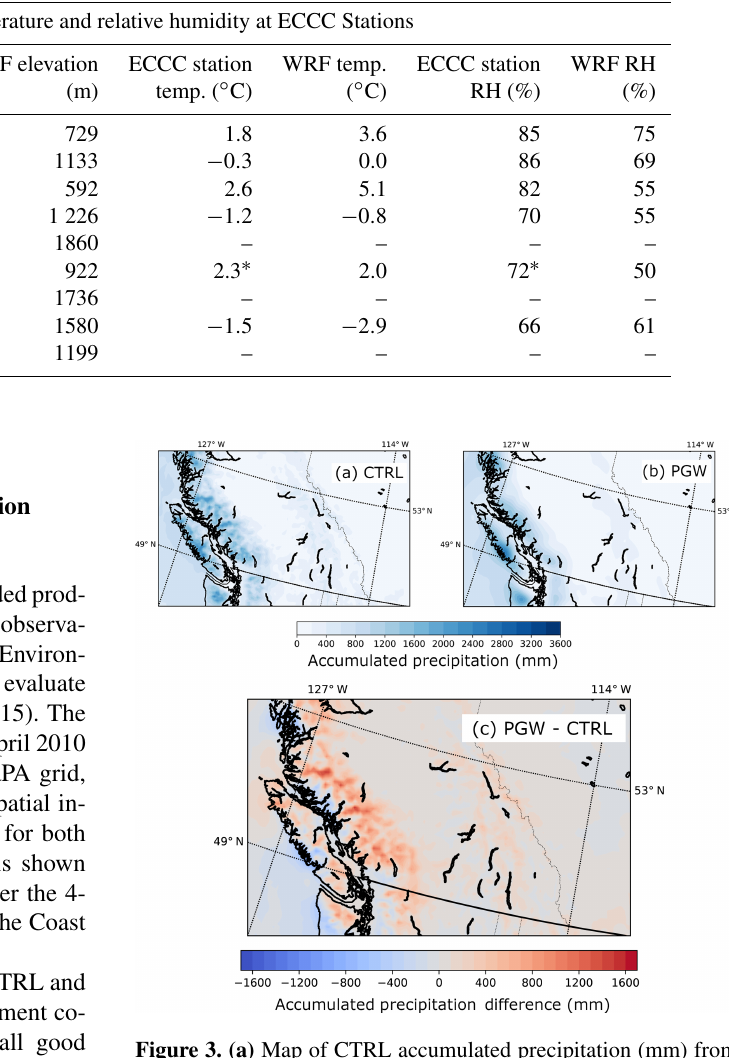
Figure 3. (a) Map of CTRL accumulated precipitation (mm) from January to April 2010. Accumulated precipitation is re-gridded onto a coarser 10km × 10km grid, according to CaPA, using a conserva- tive interpolation. (b) Map of CaPA accumulated precipitation (mm) from January to April 2010. (c) Map of accumulated precipitation difference (CTRL–CaPA; in mm) from January to April